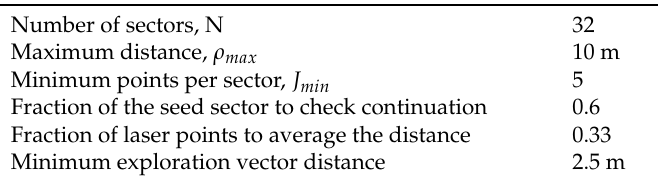
Table 2. Scan processing configuration.